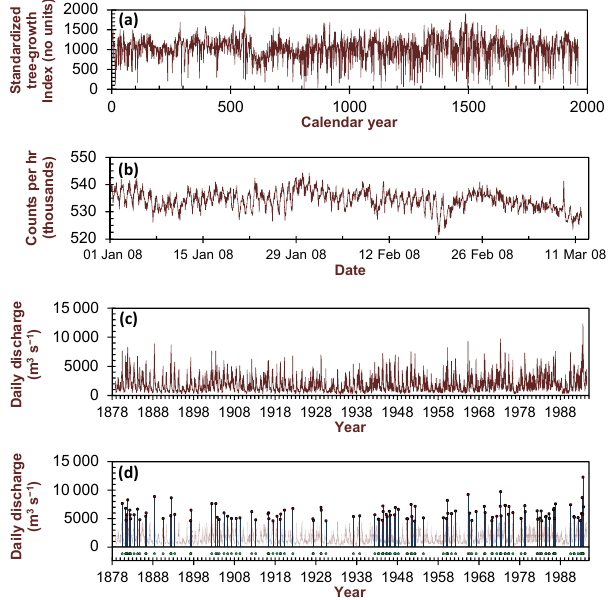
Figure 1. Example of correlations, clustering, and cyclicity ( a and b following Witt et al., 2010). (a) Tree ring standardized growth index for Bristlecone pine, White Mountain, California, USA, for the years AD0–1962 (Ferguson et al., 1994). (b) Cosmic ray neu- tron counts per hour, Beijing, China, 1 January to 11 March 2008 (NGDC, 2008). In (a) and (b) successive values in each both se- ries are positively correlated with one another, and are examples of persistent time series. (c) Maximum daily discharge, Q , for station 05474500 on the Mississippi River at Keokuk, Iowa, for 116 water years, 1878–1993 with data from Slack and Landwehr (1992) and USGS (2017) and described in Malamud et al. (1996). (d) Partial- duration flood series, where floods are the largest 116 maximum daily discharge from (c) over the 116-year period, with daily dis- charges separated by at least 30 days to be considered a flood. In our partial duration series, 48 of the 116 years have 0 floods, 33 years have 1 flood, 26 years have 2 floods, and 6/2/1 years have 3/4/5 floods. The value of these maximum daily discharges for each flood event is projected to the x -axis (daily discharge = 0m 3 s − 1 ) . Below this is shown (green dots) all events along one line, an ex- ample of a data series that is strongly clustered in time. Clustering is due to (i) seasonal effects (cyclicity) and (ii) longer-term